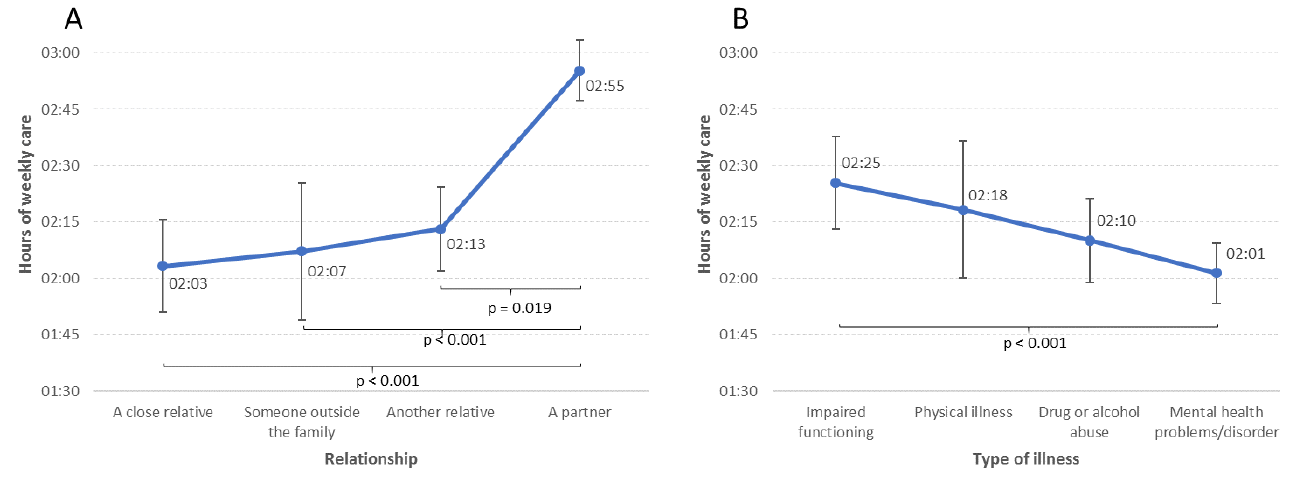
Figure 3. Hours of daily care by type of relationship between YAC and care‑receiver ( A ) and type of illness in care‑receiver ( B ).